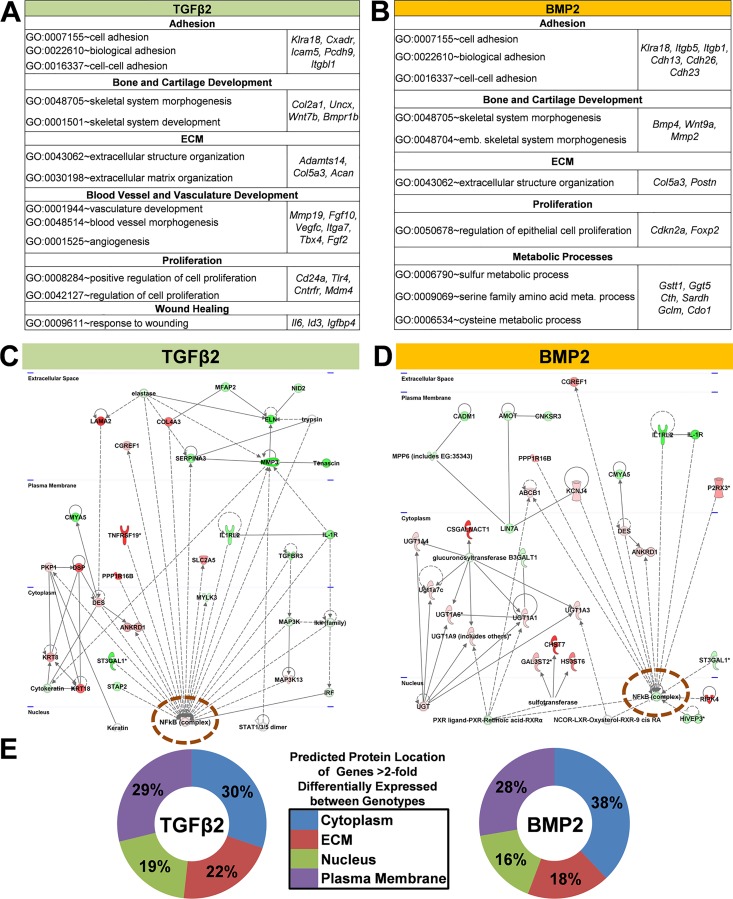
Gene regulatory network analysis identifies NF-kB signaling as a central node.Genes >2-fold (p<0.001) differentially expressed between Tgfbr3+/+ and Tgfbr3-/- epicardial cells incubated with either TGFβ2 (A) or BMP2 (B) were subjected to gene ontology analysis (using DAVID software, p<0.0001). (C-D) NF-ĸB signaling (orange circle) is a central node in representative networks generated by gene regulatory network analysis (using Ingenuity Pathway Analysis software). Green- expressed higher inTgfbr3+/+, Red- expressed higher in Tgfbr3-/-. (E) The distribution of the predicted protein location in the cell is depicted (proteins with unknown location are not shown).